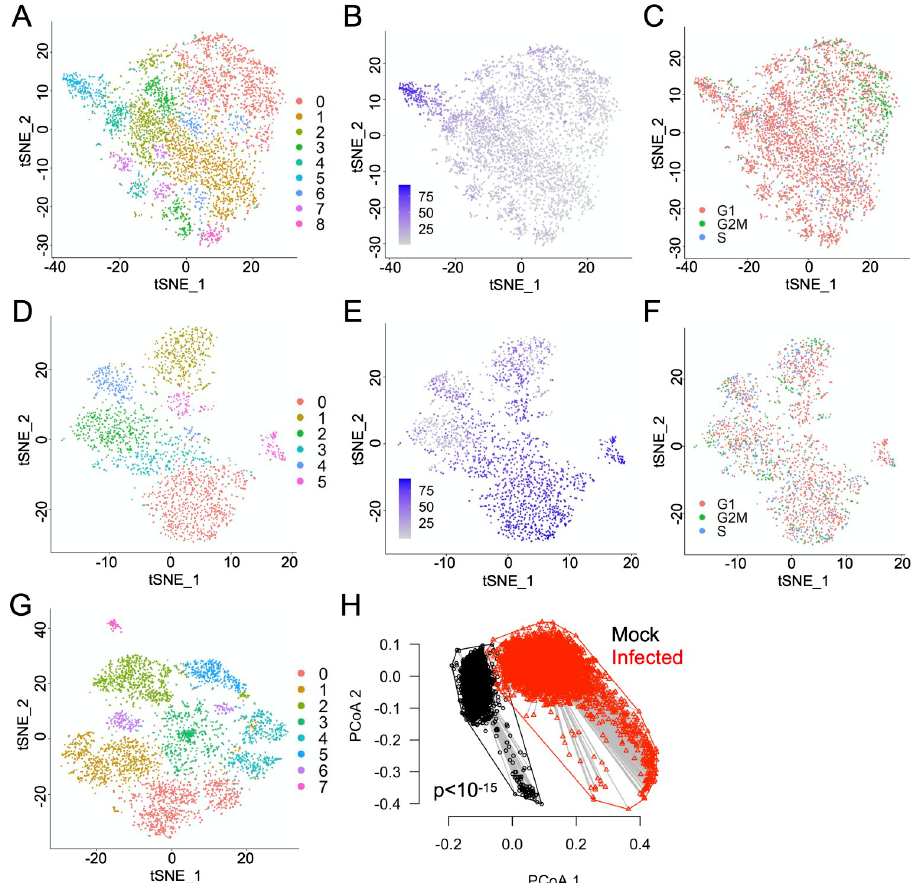
Fig 3. Significant heterogeneity in the host transcriptional response to infection. (A) tSNE dimensionality reduction plot showing all Cal07-infected A549 cells clustered based on similarity of host transcription patterns. (B) Same tSNE plot of Cal07-infected cells shown in (A) with each cell colored by the percentage of total cellular poly(A) RNA that is viral in origin. (C) Same tSNE plot of Cal07-infected cells shown in (A) with each cell colored by predicted cell cycle stage, as determined by the Scran package. (D) Same figure as (A) for Perth09. (E) Same figure as (B) for Perth09. (F) Same figure as (C) for Perth09. (G) tSNE dimensionality reduction plot showing mock A549 cells from Cal07 experiment clustered based on similarity of host transcriptional patterns. (H) Principle coordinate axes (PCoA) plot comparing the multivariate dispersions for mock (black) and Cal07-infected (red) A549 cells. The first two axes (PCoA 1 and PCoA 2) in the multivariate homogeneity of group dispersions analysis are used.